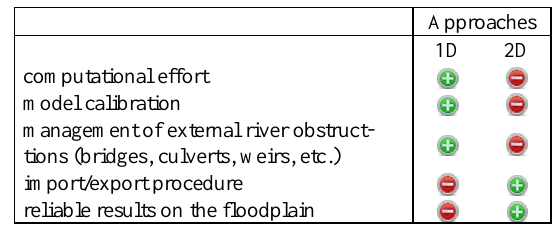
Table 1. Pros and cons of the GRASS modules.